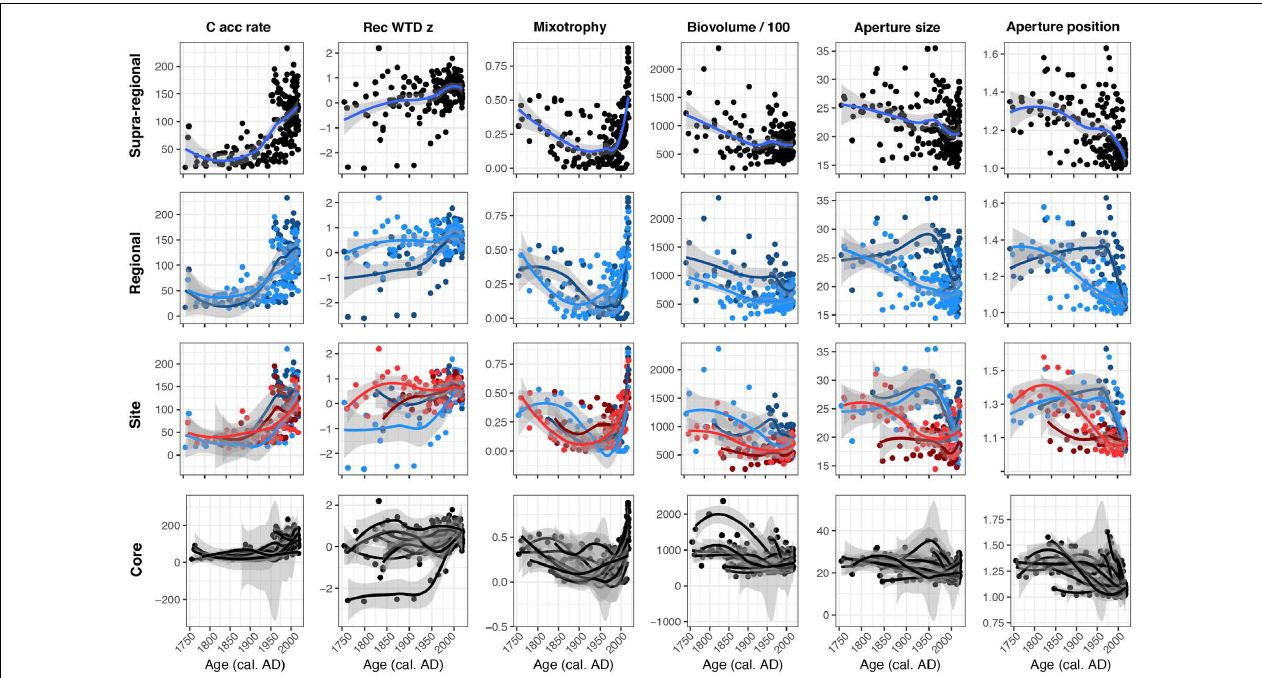
FIGURE 5 | Locally estimated scatterplot smoothing plots showing supra-regional, regional, site and core level variations of carbon accumulation rates (C acc rate; g C m − 2 yr − 1 ), reconstructed water-table depth z score (Rec WTD z ), mixotrophy, biovolume/100 ( µ m 3 ), aperture size ( µ m) and aperture position. In the Regional panels, dark blue represents region Kuujjuarapik and light blue represents Radisson. In the Site panels, dark blue represents site K2 and light blue represents K1P, while dark red represents site LG2 and light red represents